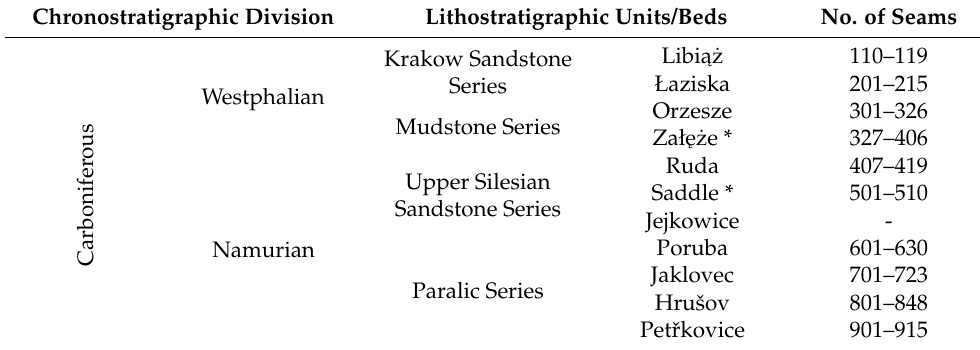
Figure 2. Percentage contribution of coal and surrounding rock in the geological sections of the Mudstone Series and the Upper Silesian Sandstone Series in the USCB in Poland. Table 1. Stratigraphic classification of Upper Carboniferous formations of the Polish part of the USCB (simplified version, after [23]).